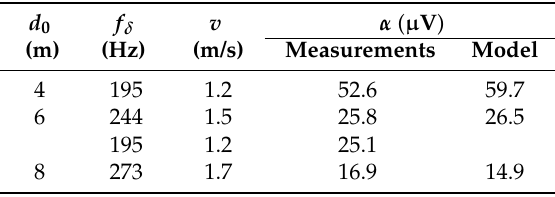
Figure 6. People detection results. ( a ) Time domain output signal corresponding to a person at a 6-m distance with a relative speed of about 1.5 m/s. ( b ) Frequency domain output signal obtained performing the FFT of panel ( a ). The main peak corresponds to a Doppler frequency of 244Hz. Table 1. People detection: scale constant α